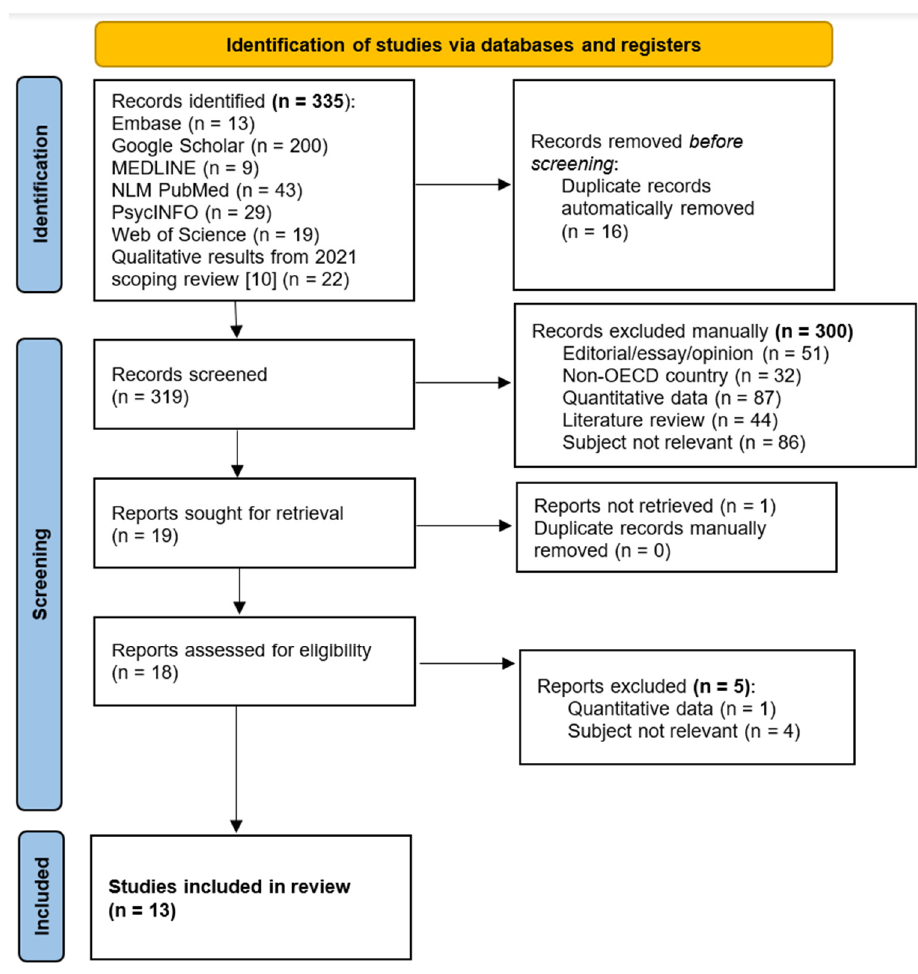
Figure 1. PRISMA literature search flowsheet [12].